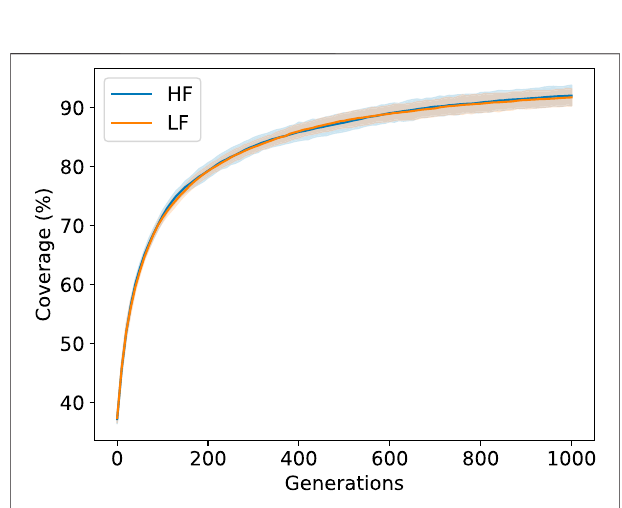
FIGURE 7 | MAP-Elites archive coverage for the two different environments across the 10 runs.